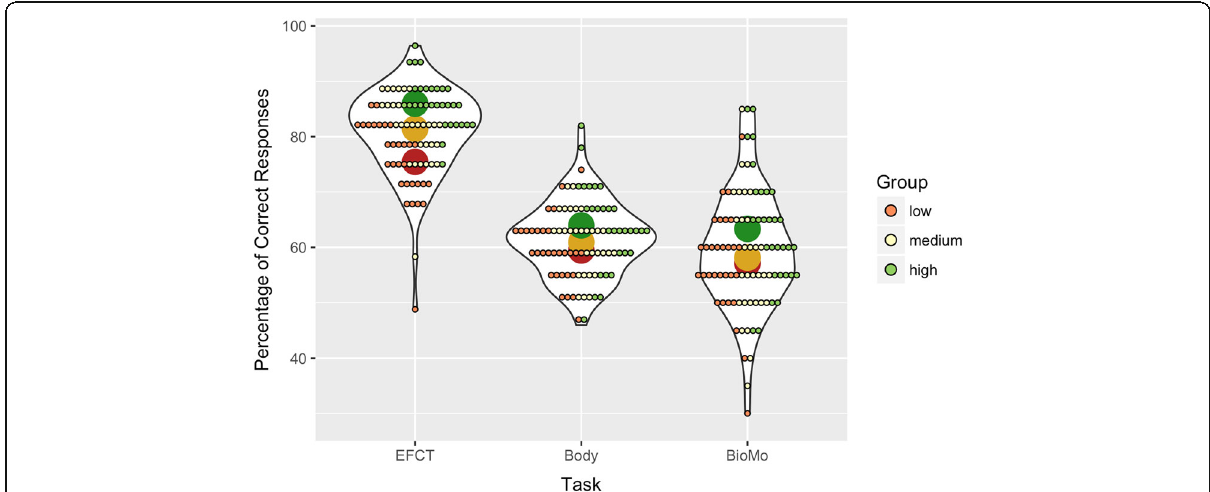
Fig. 2 Violin plots show performance accuracy of each participant (small circles), colour coded by face-recognition ability score on the GFMT (low, red; medium, yellow; high, green) for each of the tasks (Expertise in Facial Comparison Test (EFCT) (Face), Body and BioMo (Biological Motion). Task is on the x axis, and accuracy (% correct) is on the y axis. For each task, mean performance in each face-recognition-ability group (low, red; medium, yellow; high, green) is depicted by a large coloured